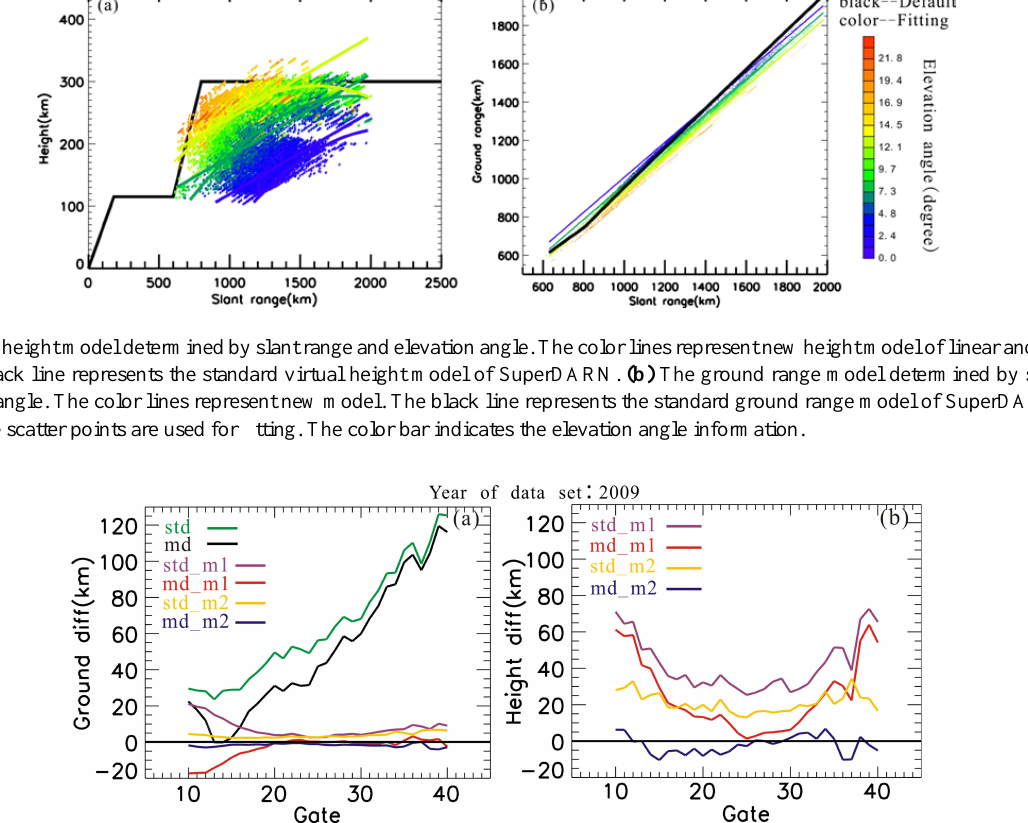
Fig. 8. (a) The standard and mean deviation of ground range between the results of model and the ray tracing for the data set in 2009. The green and black lines indicate the results of the standard SuperDARN model (std, md), the purple and red lines are for the linear fitting model (std m1, md m1), and the yellow and blue lines are for the quadratic fitting model (std m2, md m2). (b) The height deviation between the results of the fitting model and the ray tracing. The purple and red lines are for the linear fitting model (std m1, md m1), and the yellow and blue lines are for the quadratic fitting model (std m2, md